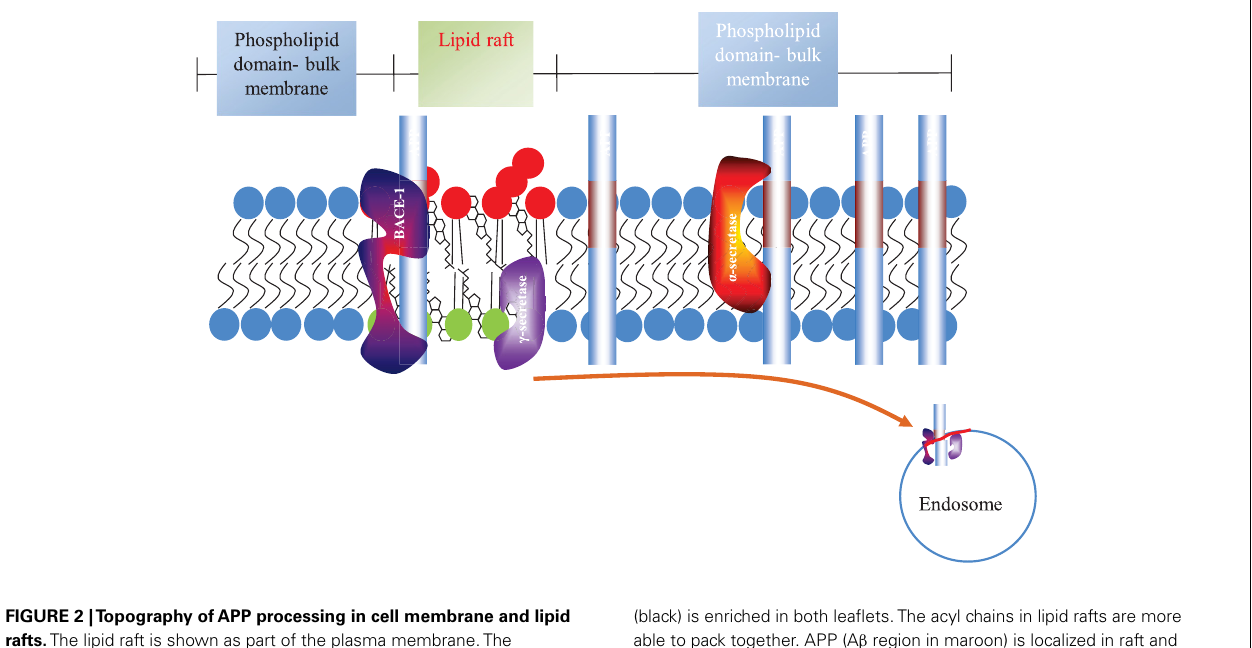
FIGURE 2 |Topography ofAPP processing in cell membrane and lipid rafts. The lipid raft is shown as part of the plasma membrane.The phospholipid domain (light blue) is separate from the lipid raft.The latter is enriched in glycosphingolipids and sphingomyelin (red) on the exofacial leaflet and glycerolipids (e.g., phosphatidylserine and phosphatidylethanolamine; green) on the cytofacial leaflet. Cholesterol